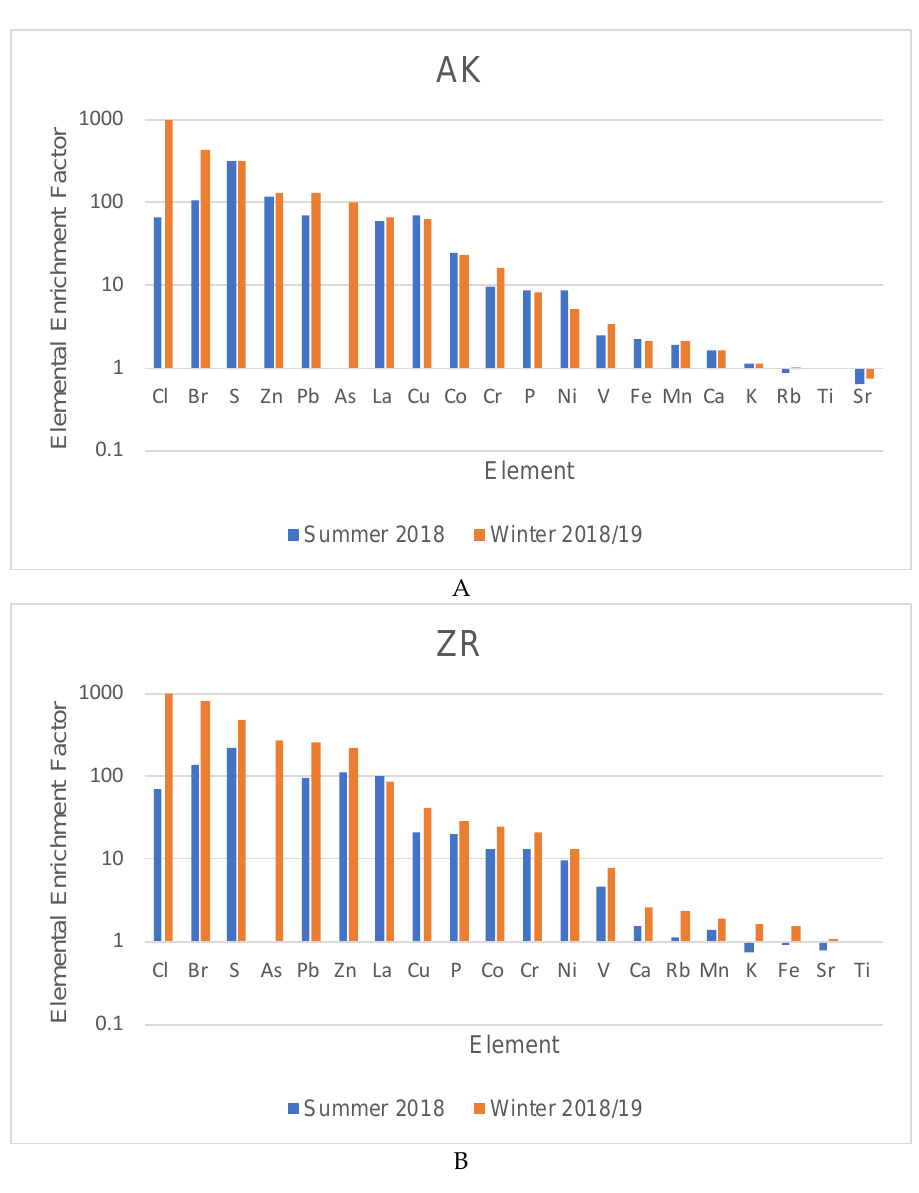
Figure 5. Elemental Enrichment Factors for elements at traffic-dominated (AK) ( A ) and urban-background (ZR) ( B ) stations, (calculated for summer and winter seasons.